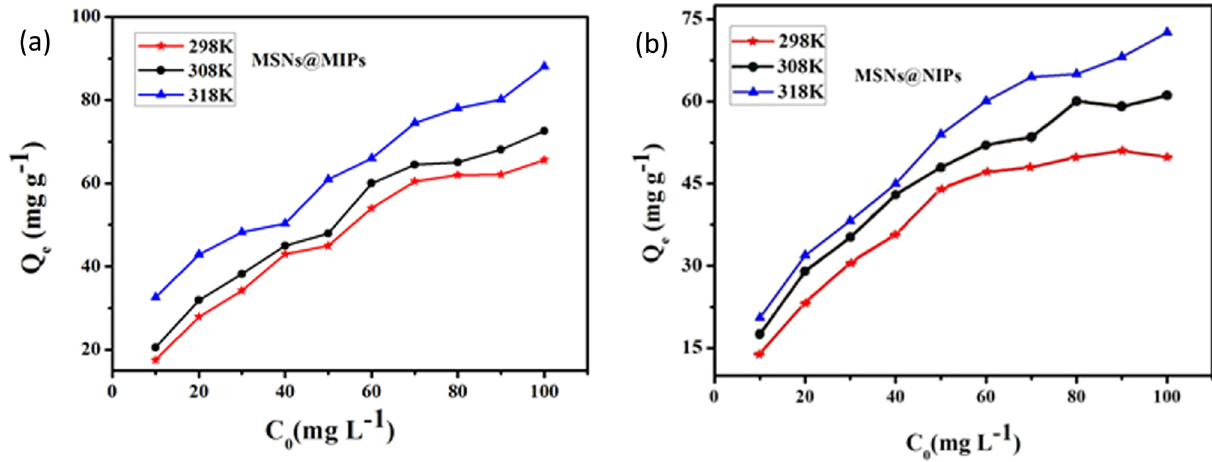
Figure 6: Adsorption isotherm curves of ( a ) MSNs@MIPs and ( b )